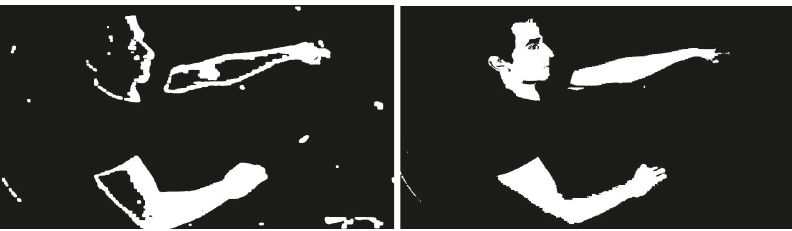
Figure 3: Left and right images show a sample for skin segmentation result without and with training the pixels spatial information,